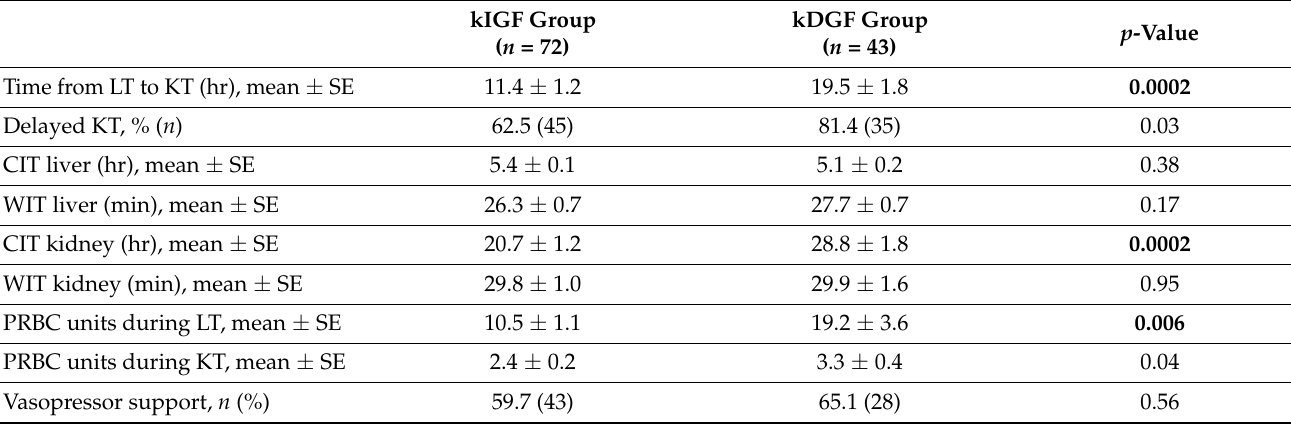
Table 3. Comparisons of operative variables by group (kIGF vs. kDGF) 1